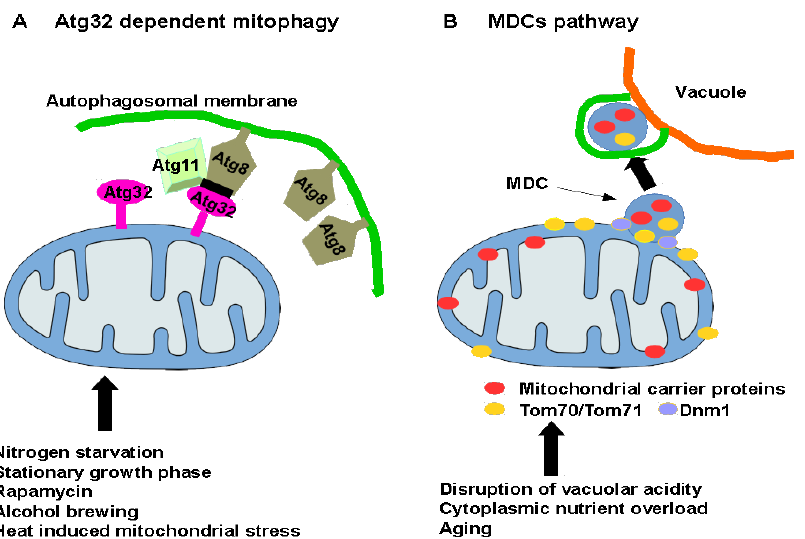
Figure 1. Pathways involved in selective removal of mitochondria in yeast. ( A ) Conventional mitophagy relies on receptor protein Atg32. Following the activation of mitophagy, Atg32p binds to Atg8p conjugated to phosphatidylethanolamine at PAS, and Atg11, an adaptor protein, to confer selectivity for mitophagy. ( B ) The mitochondria-derived compartments (MDC) pathway. This process selectively sequesters a group of mitochondrial membrane proteins, mainly carrier family proteins, into vesicles that bud from the mitochondria in a Dnm1- and Tom70/71-dependent way followed by elimination by autophagy.